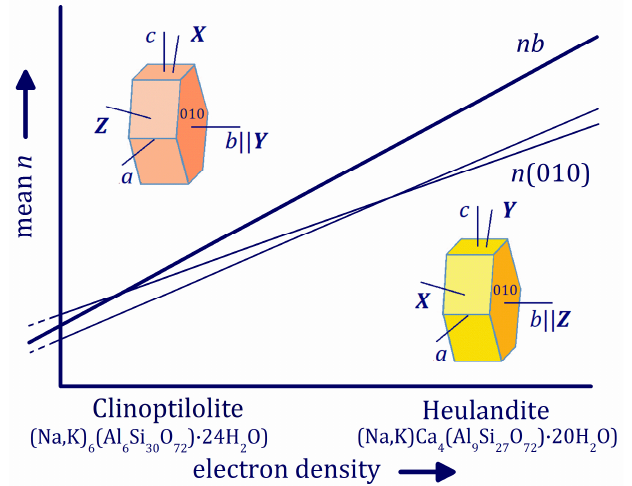
Figure 5. Optical properties of HEU zeolite family. Adapted with permission from Palmer, J.L., Gunter, M.E., Am Mineral ; Mineralogical Society of America, 2000 [73].